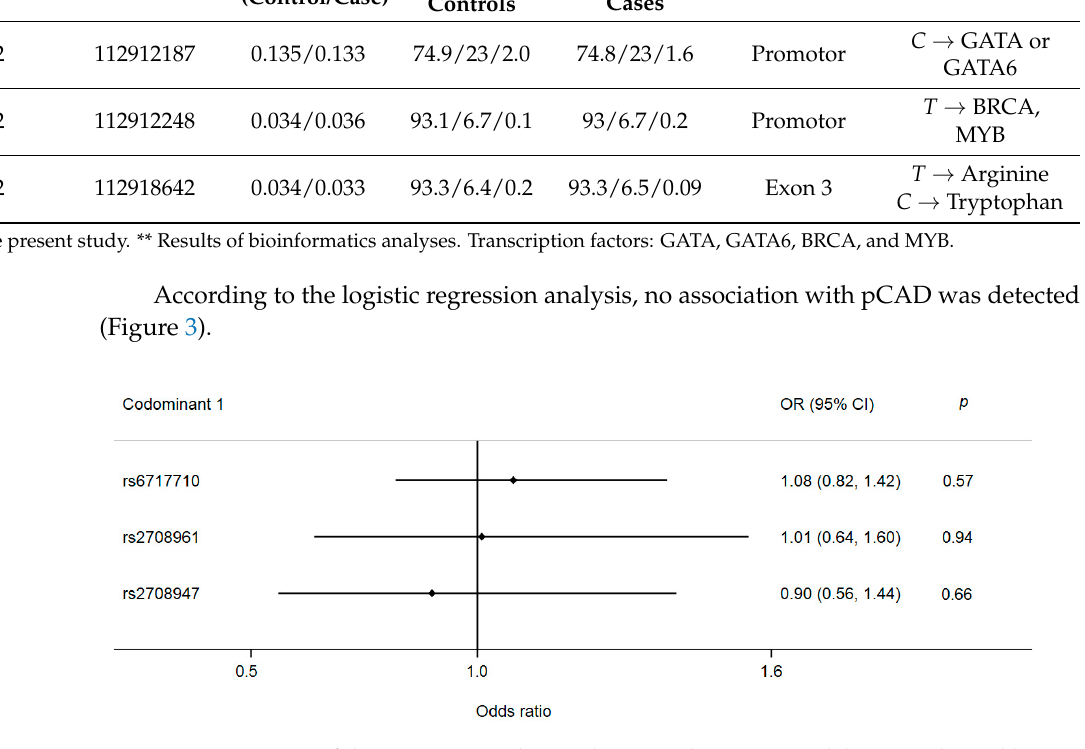
Figure 3. Association of the IL-37 gene polymorphisms with pCAD. Models were adjusted by age, sex, BMI, diabetes, LDL-c, hypertension, and smoke. Codominant 1 model = heterozygous vs. major allele homozygous.